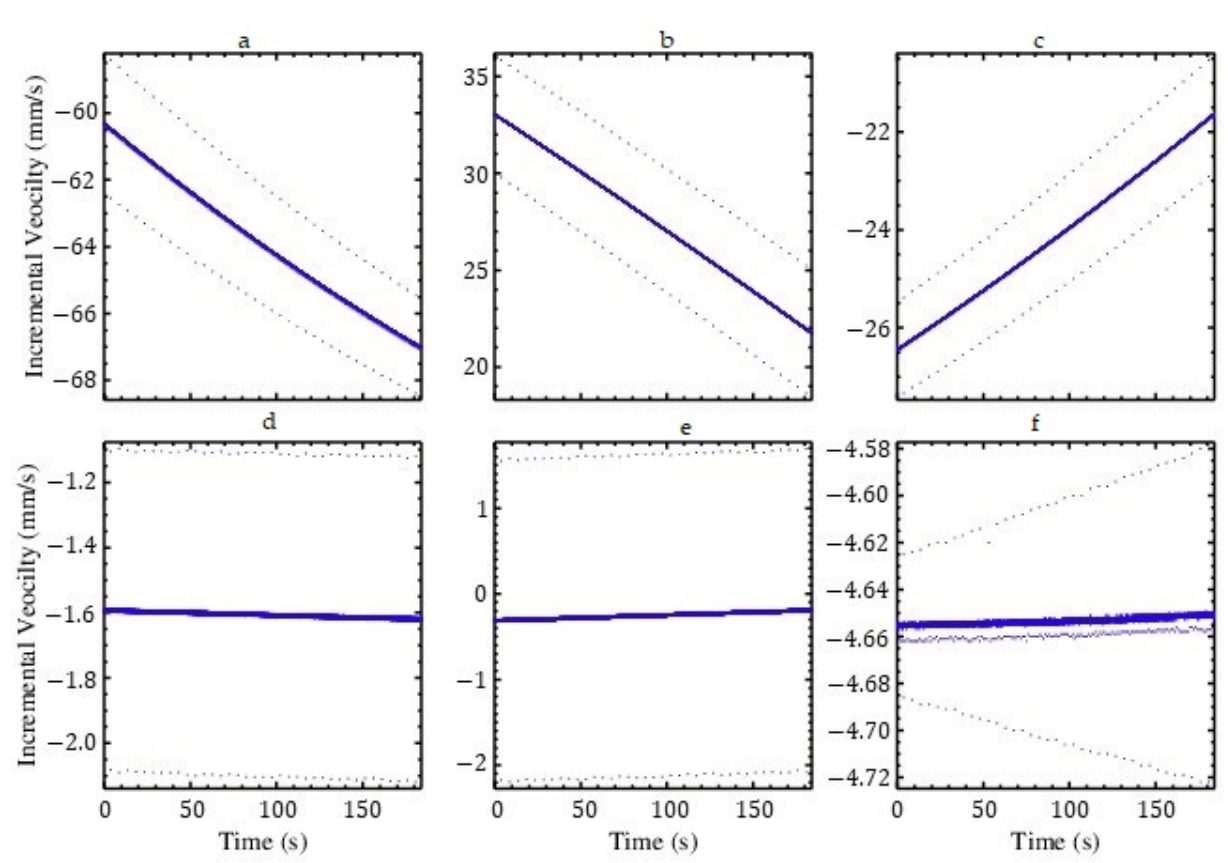
Figure 8. Incremental velocity vectors as a function of time for (a-c) COSMIC-2 and (d-f) GPS for the RO measurements at 00:21 Z on October 09, 2019.